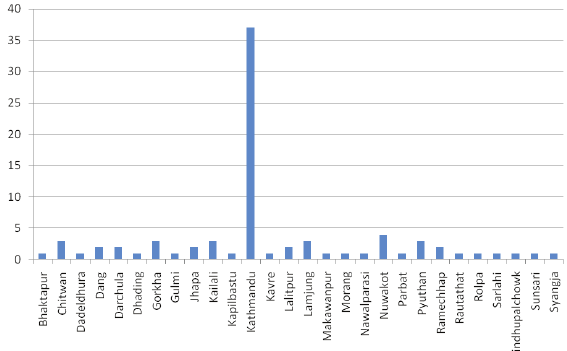
Figure 2: Geographical distribution of the patients Table 1: Age group and side